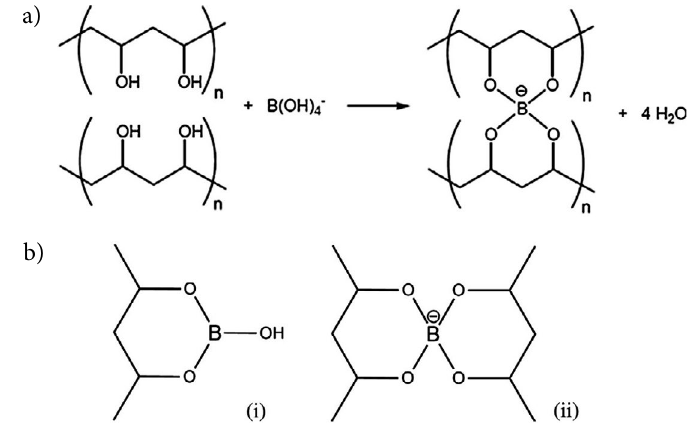
Fig. 1. Cross linking condensation reaction of polyvinyl alcohol with